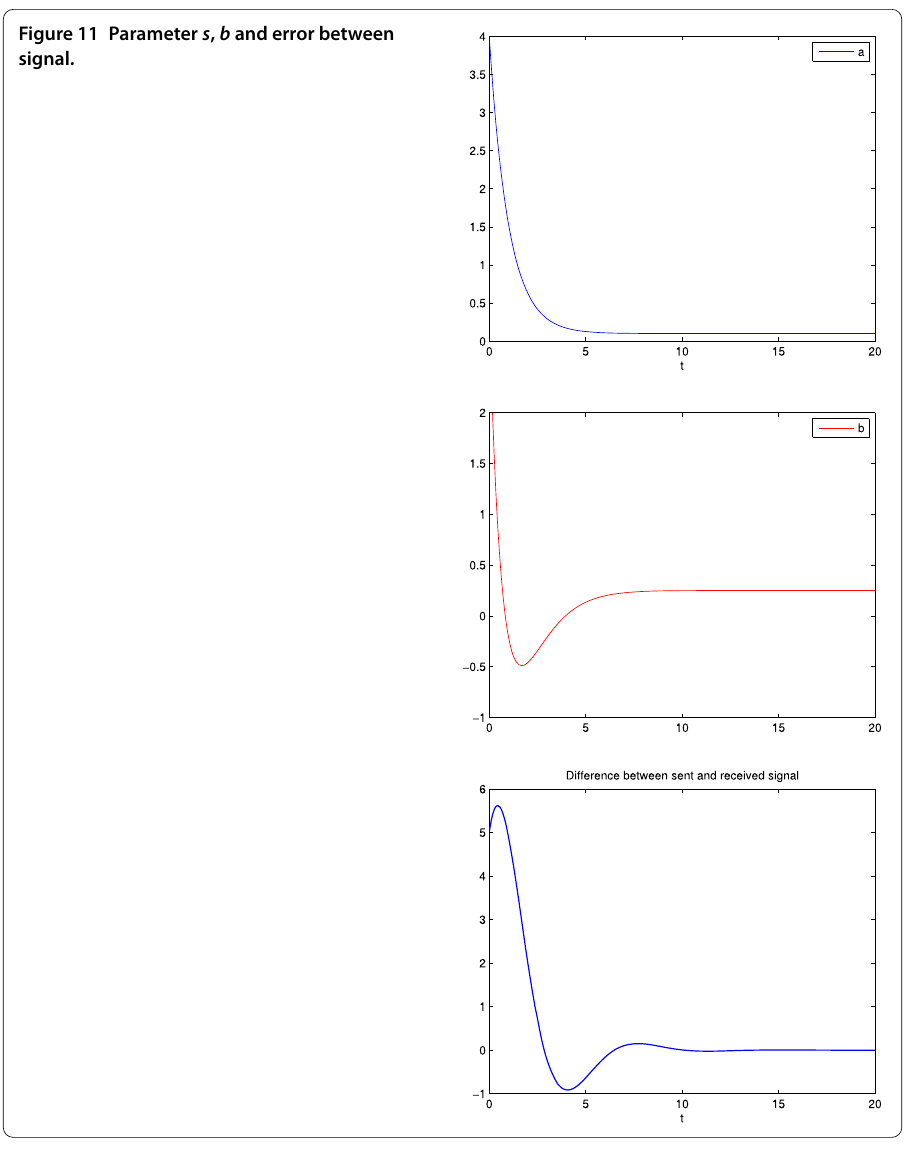
Figure 11 Parameter s , b and error between